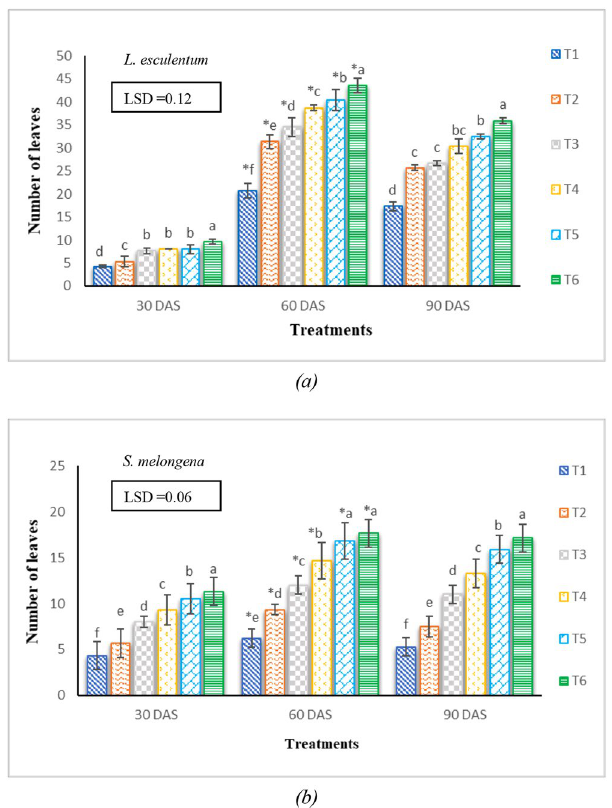
Figure 5. Effects of vermicomposted fly ash applied at different rates on the number of leaves in Lycopersicon esculentum and Solanum melongena at different durations. Illustration: Values are in Mean ± SD; (n = 3). Means with bars of different patterns followed by the same letter are not significantly different at p < 0 . 05 (One-way ANOVA followed by LSD test). The normality and homogeneity of variances were verified, respectively, by Shapiro-Wilk and Levene values at p > 0 . 05 . * Repeated measures ANOVA was applied to determine significant differences between the number of leaves in different treatments at different